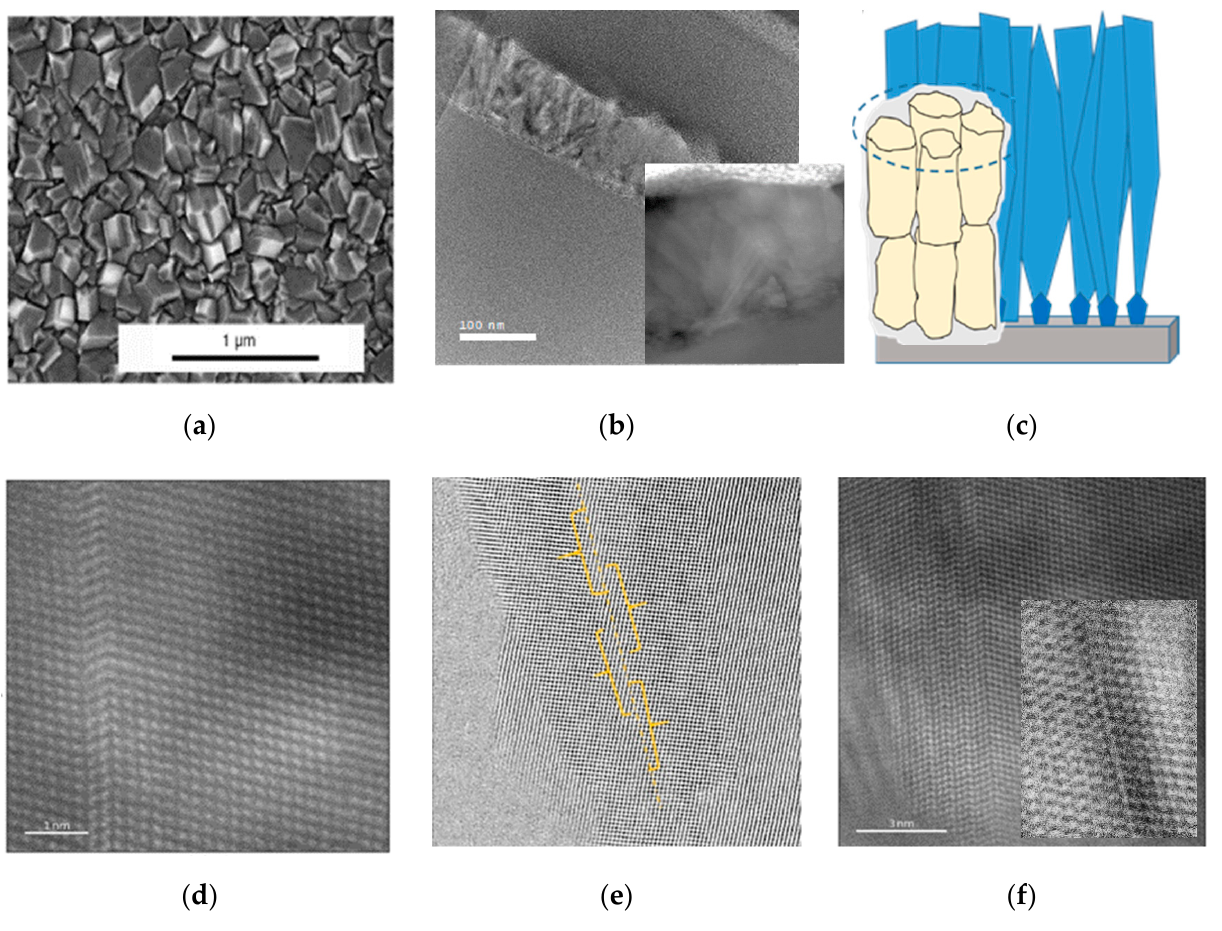
Figure 1. ( a ) Scanning electron micrograph shows diamond grains distribution. ( b ) A cross-section transmission electron microscopic image shows the columnar microstructure of the films. (Scale bar 100 nm) ( c ) Columnar growth of the diamond nanocrystals from the seeded substrates is shown schematically. High-resolution TEM imaging indicates high crystalline order of individual grains with sharp distinctive grain boundary edges ( d ) distortions (scale bar 1 nm) and ( e ) the modulation in width. ( f ) A close observation shows distorted hexagonal rings on the interface (scale bar 3 nm) (see inset of the figure).